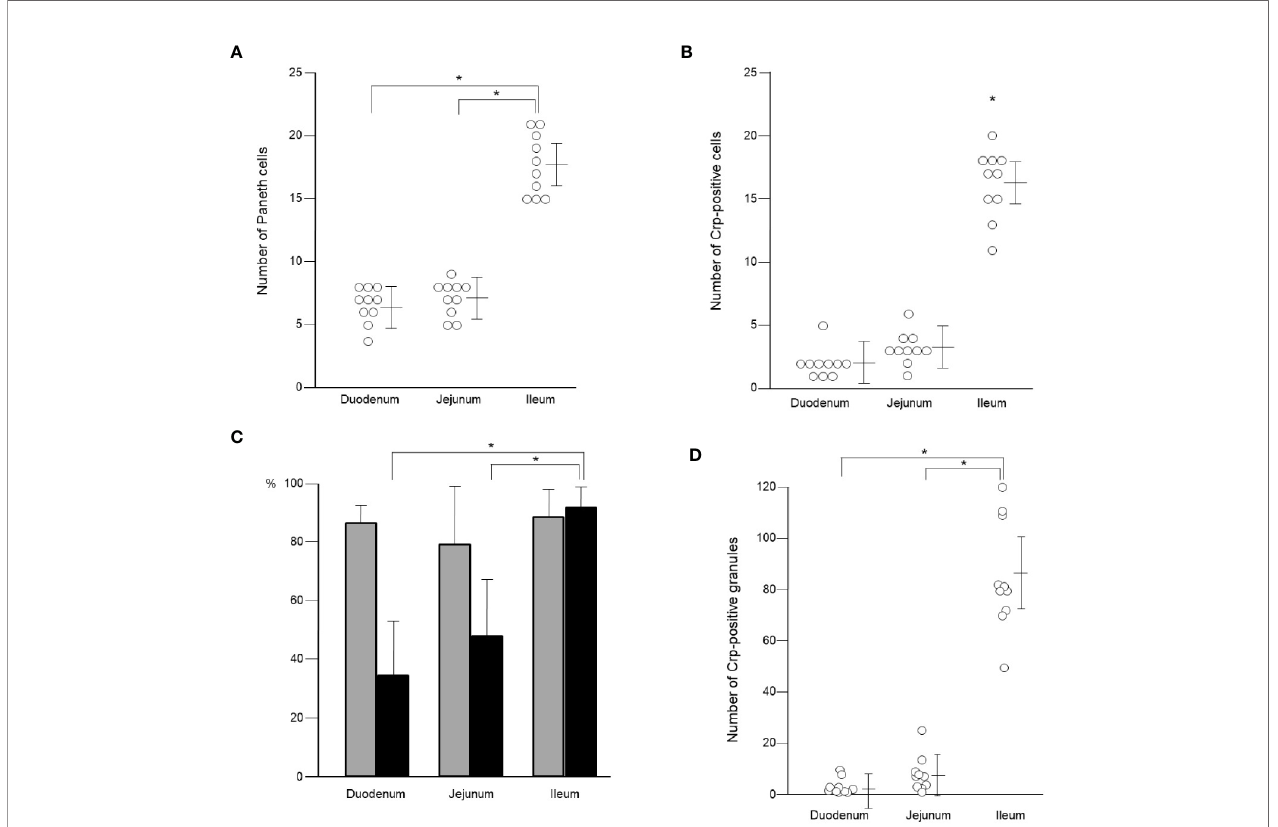
FIGURE 3 | Number of Paneth cells and their granules in single crypt of duodenum, jejunum, and ileum. Number of Paneth cells in single crypt of duodenum, jejunum, and ileum (A) . Number of Crp-positive cells in single crypt of duodenum, jejunum, and ileum (B) . Percentage of lysozyme-positive (gray column) and Crp- positive (black column) Paneth cells in single crypt of duodenum, jejunum, and ileum (C) . Number of Crp-positive granules in single-crypt of duodenum, jejunum, and ileum (D) . n = 10 for each, mean ± SD, *p <